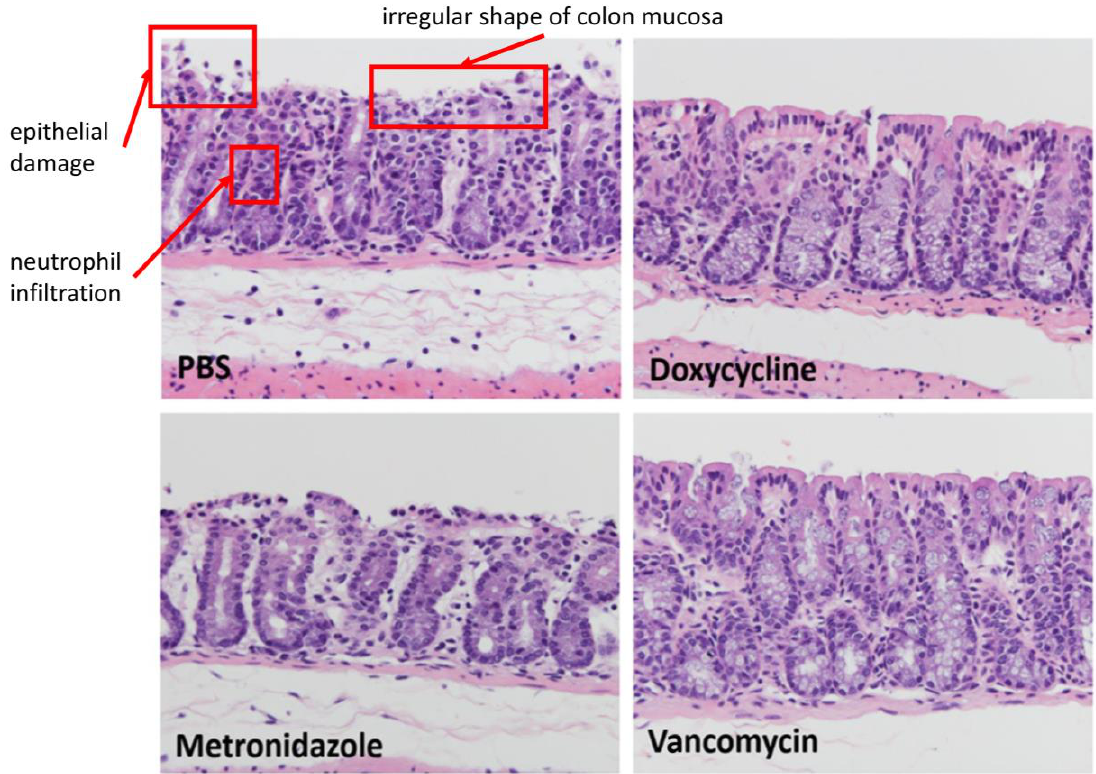
Figure 6. Epithelial inflammation (neutrophil infiltration, epithelial damage, and irregular shape of colon mucosa) in the colons of Clostridioides difficile -infected mice orally receiving phosphate-buffered saline (PBS), doxycycline, metronidazole, or vancomycin therapy (hematoxylin and eosin staining of colons, magnification 400×).